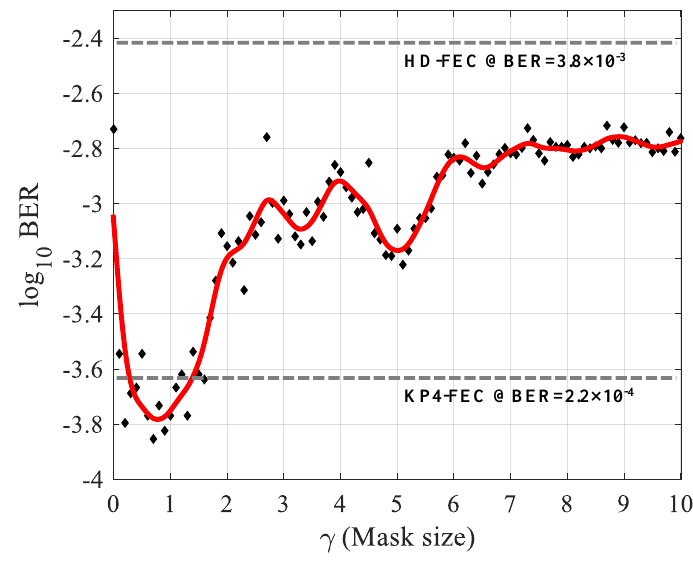
Figure 6. Relationship between γ and BER.